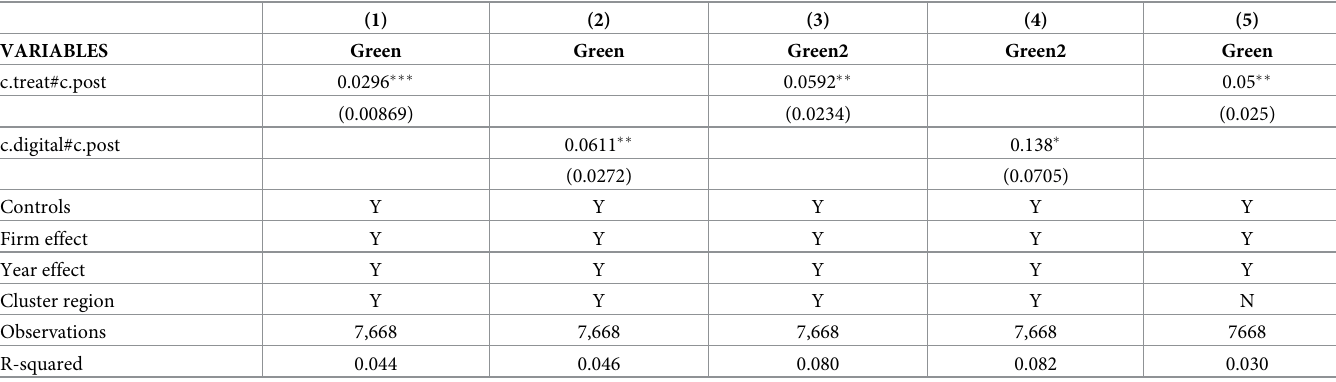
Table 7. Difference in difference